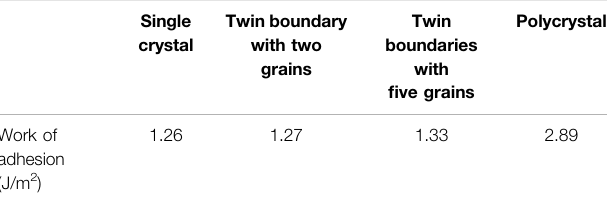
TABLE 3 | Works of adhesion of the different models.